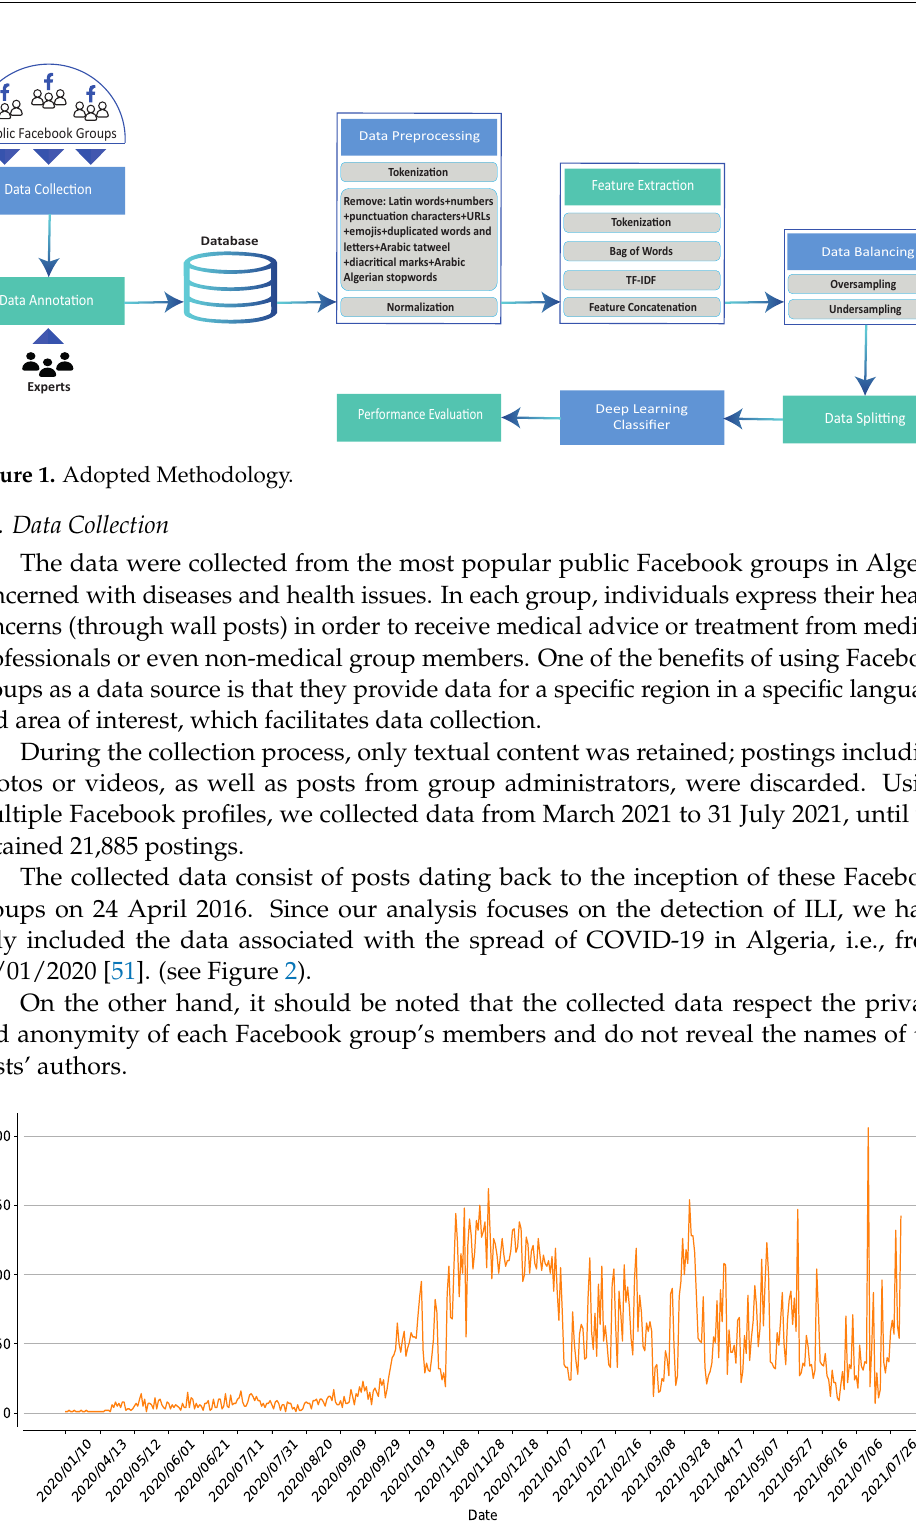
Figure 2. The volume of data collected from 01/01/2020 to